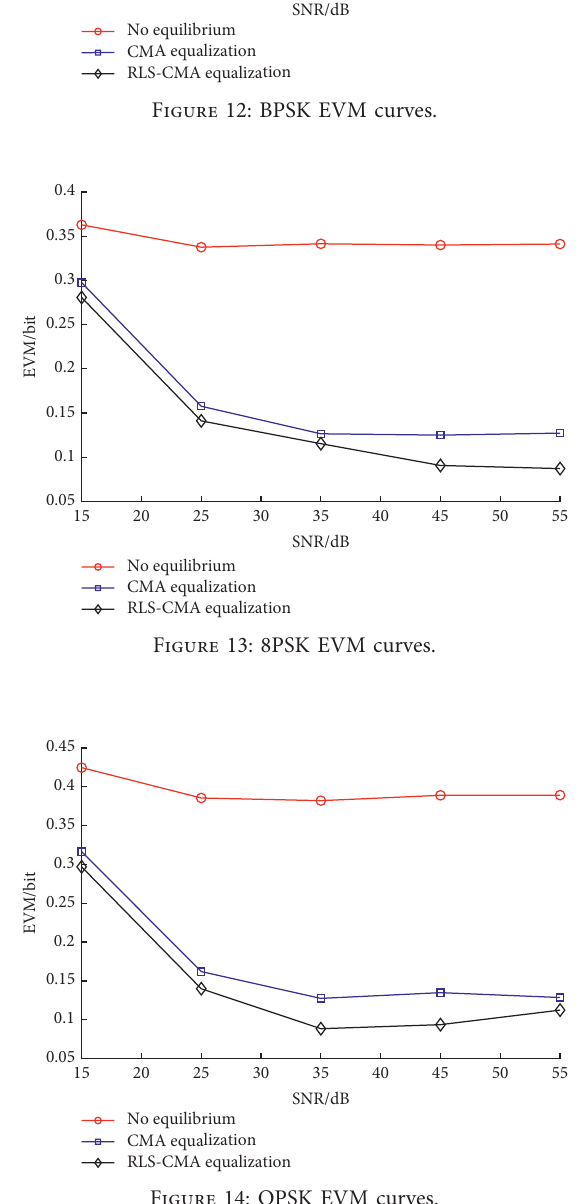
Figure 14: QPSK EVM curves.